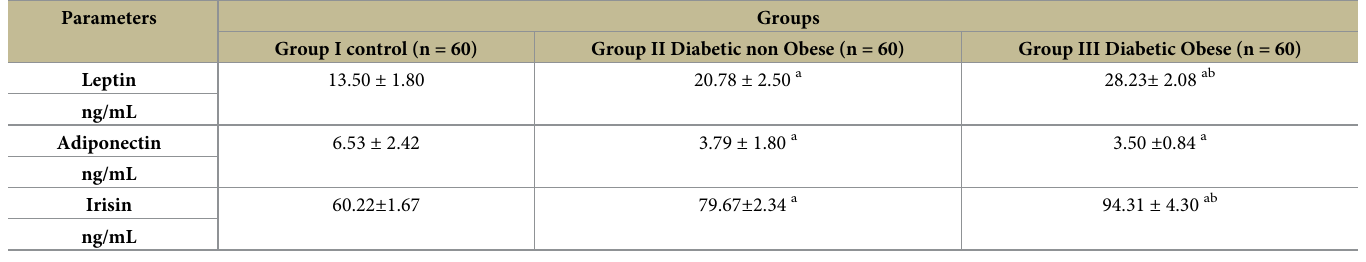
Table 3. Serum leptin, adiponectin and Irisin levels in the different studied groups represented as mean ± SEM.